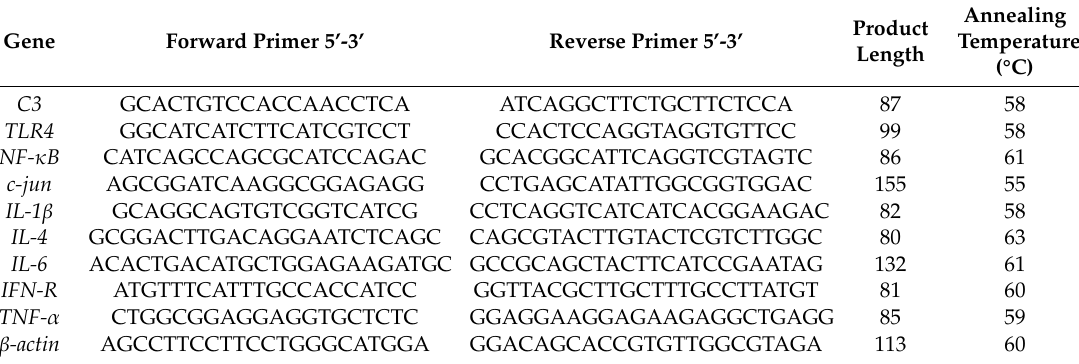
Table 2. List of primer sequences for quantitative real-time